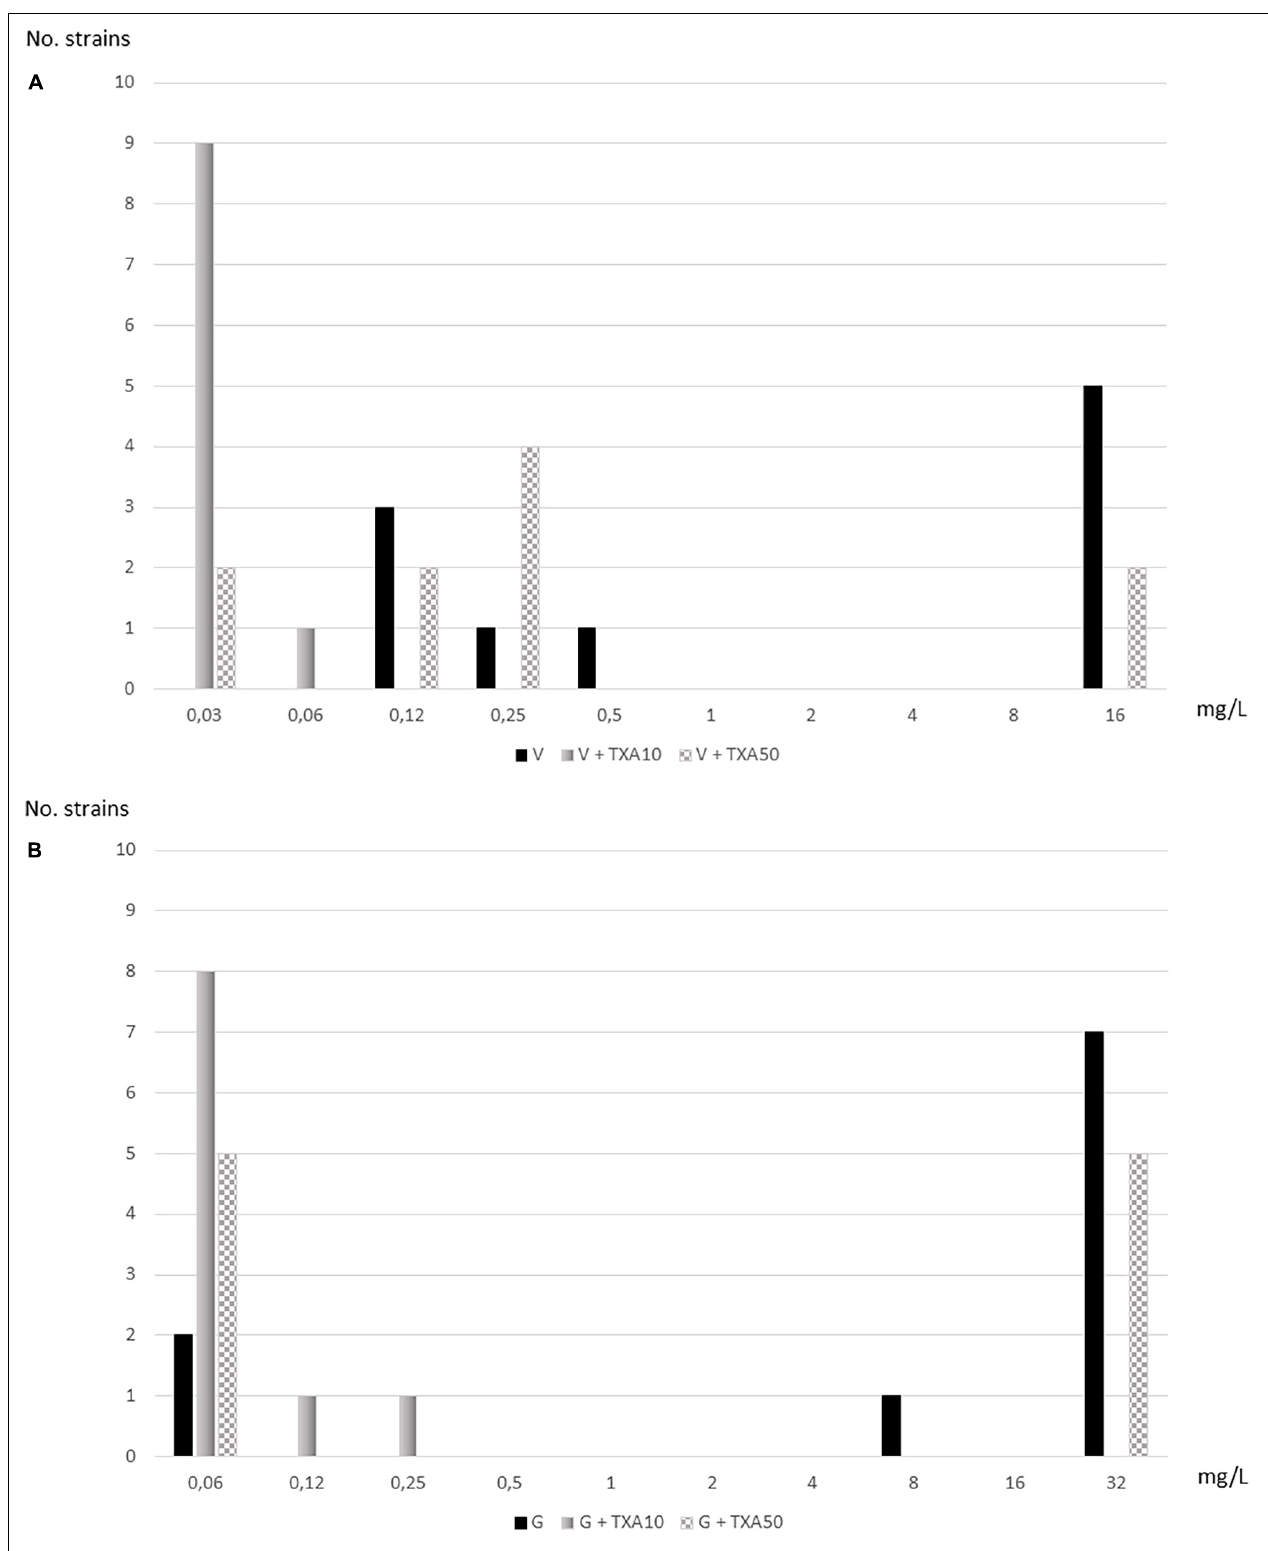
FIGURE 3 | Distribution of strains according to serial dilutions of vancomycin and gentamicin alone and in combination with tranexamic acid (TXA) using the automated turbidity method. (A) Vancomycin. (B) Gentamicin.